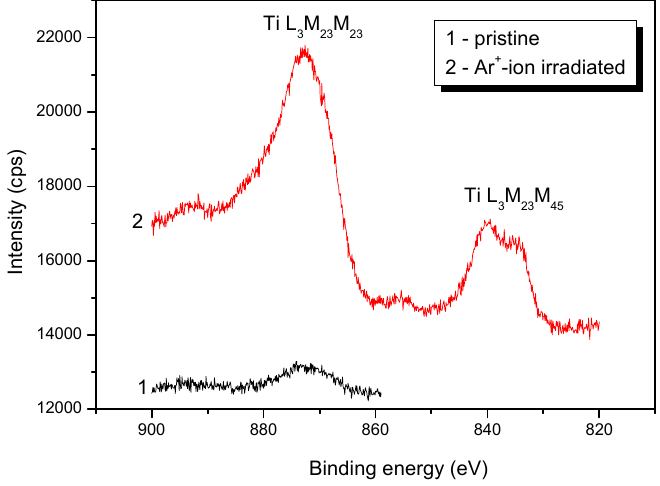
Figure 10. Auger lines TiL 3 M 23 M 23 and TiL 3 M 23 M 45 of the investigated specimen before (1) and after (2) cleaning its surface with Ar + ions.